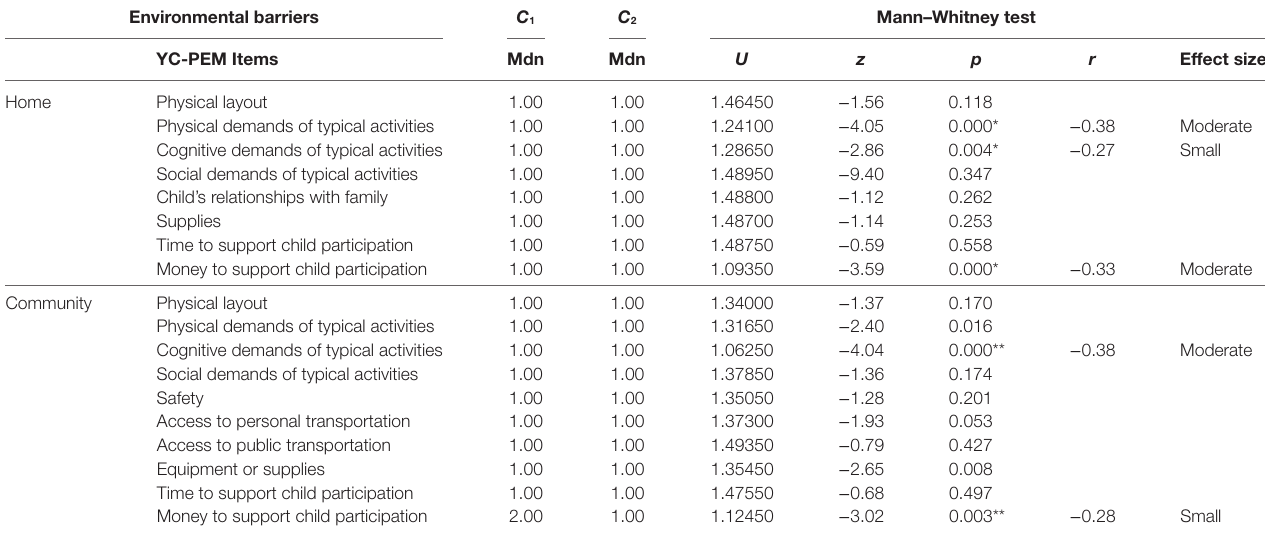
TaBle 5 | Differences between children with SEN ( C 1 ) and children without SEN ( C 2 ) in environmental factors at home and in the community. environmental